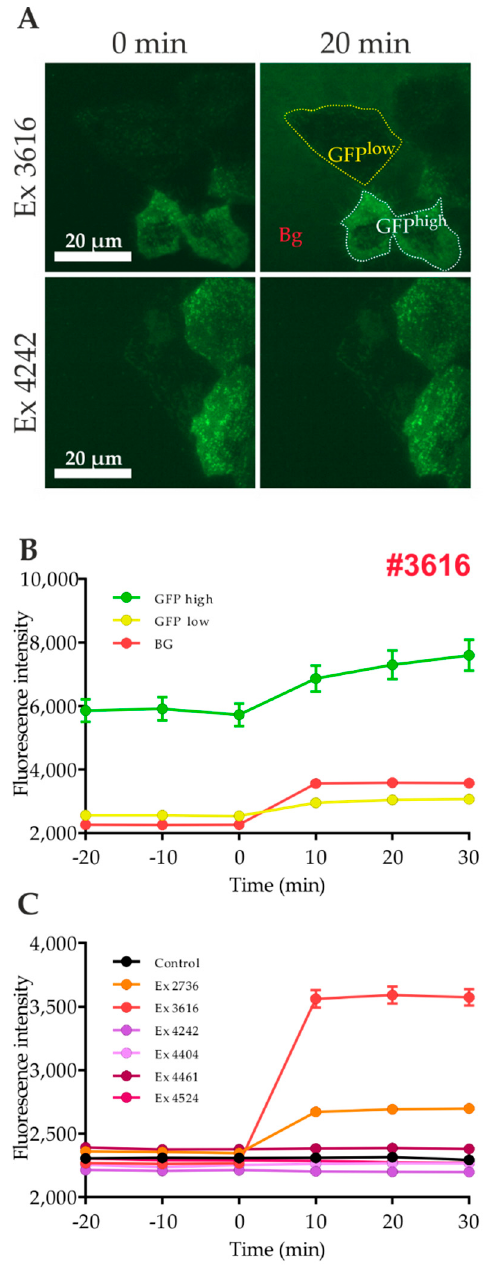
Figure 3. Analysis of the potential autofluorescence of the tested plant extracts by objective-type TIRF microscopy. HeLa cells stably expressing a GLUT4-myc-GFP fusion protein were seeded in 96-well microtiter plates and starved for 3 h in HBSS buffer on the following day. Images in the TIR configuration were taken before and after stimulation with the indicated extract for 10, 20, and 30 min. ( A ) The fluorescence signal intensity of cell-free regions (background, bg) and regions with cells expressing high or low levels of GLUT4-myc-GFP (GFP high , GFP low ) were separately analyzed. The results of a representative extract (#3616) with strong autofluorescence are shown in ( B ). All plant extracts under study were tested for their background fluorescence intensities ( C ). Values represent the mean ± SEM ( n > 200).